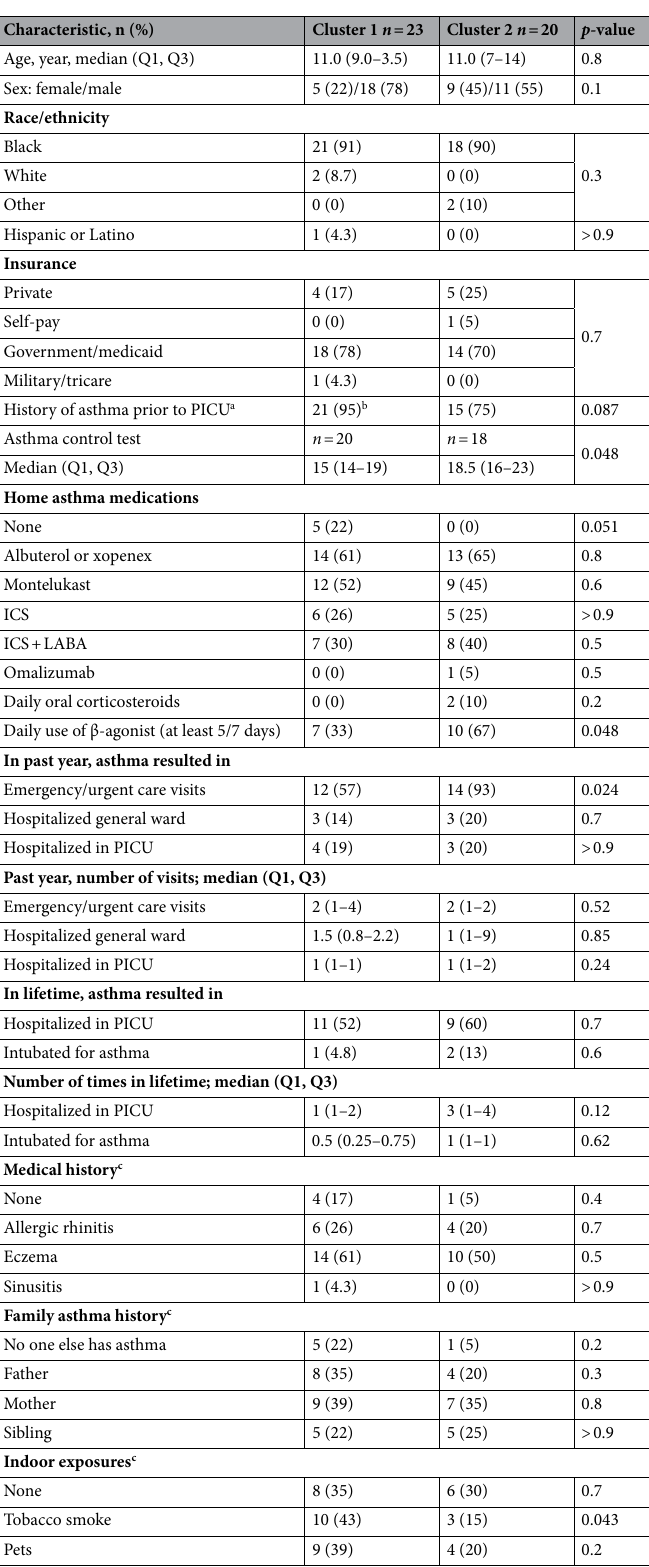
Table 1. Demographics and Asthma History of the Participants by Cluster. a Pediatric intensive care unit; b One Missing; c More than one condition can be selected and frequency total may add up to more than